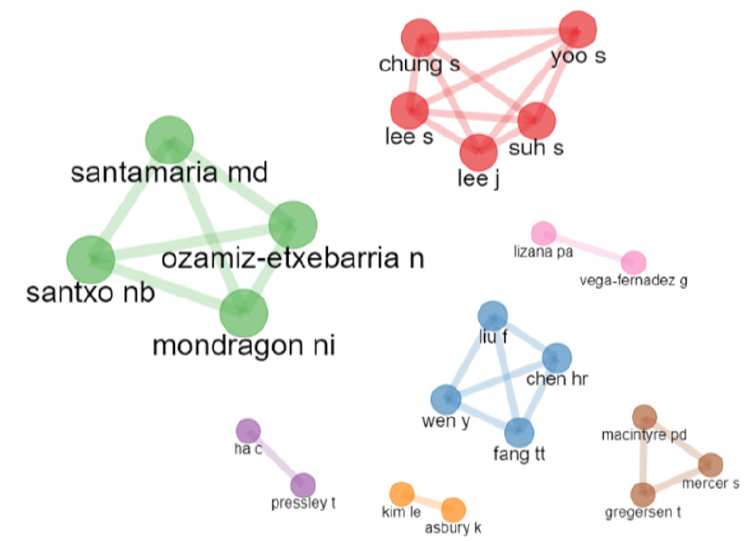
Figure 8. Co-authorship networks ( ≥ 1 collaboration).